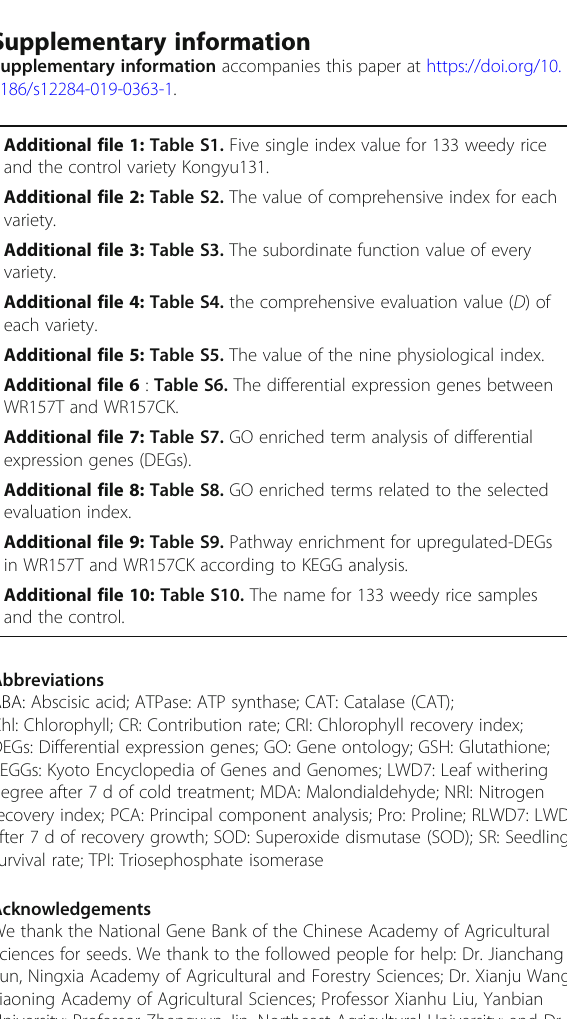
Table 5 The investigation of Leaf Wither Degree under the cold stress